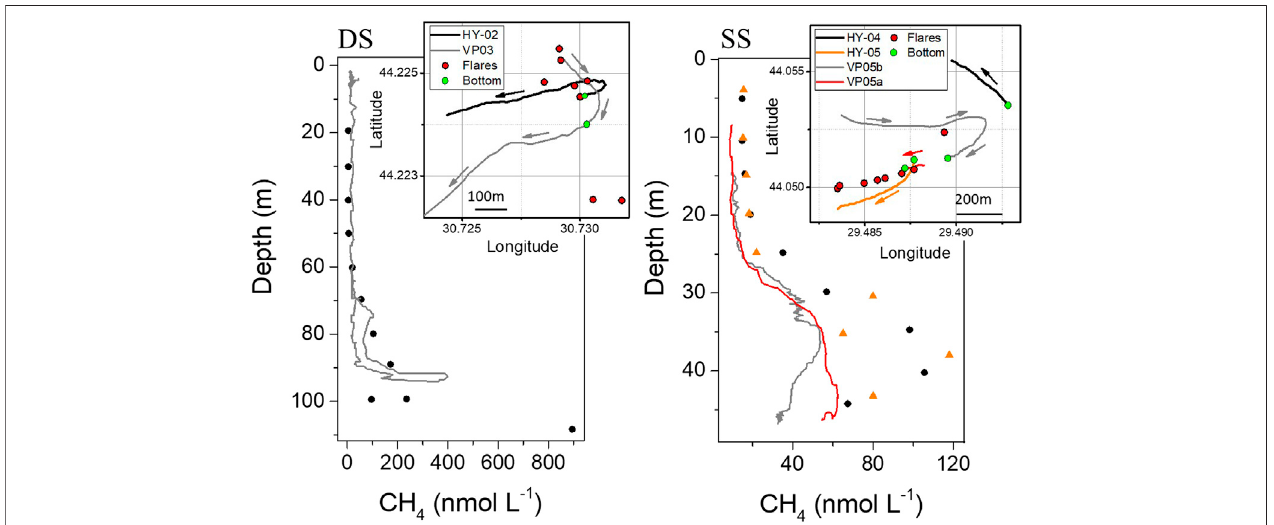
FIGURE 5 | Comparison between the dissolved methane measurements from MILS (VP) and discrete water sample (HY) techniques at the two sites (average concentrations between PT and HS methods are reported). The inserts show the trajectory of the vessel during the measurements, which were performed at different time and without dynamic positioning of the vessel. Red circles in the maps report the location of the fl ares identi fi ed from the acoustic survey. Arrows in the inserts represent the time direction of the measurement, and green dots the location of the bottom of the pro fi le.